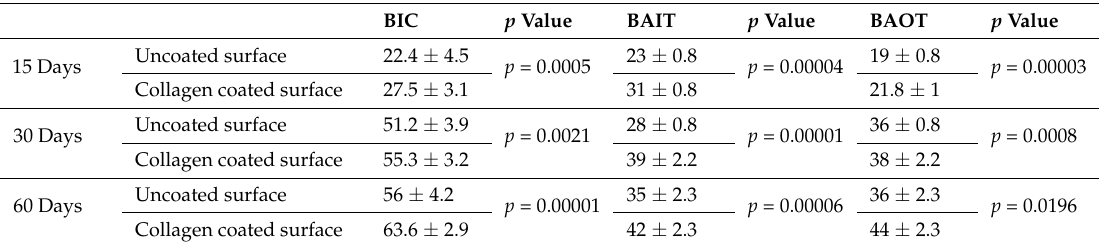
Table 2. Means and SD of the measured Micro-CT BAIT and BOAT ratios and histomorphometric BIC ratios.